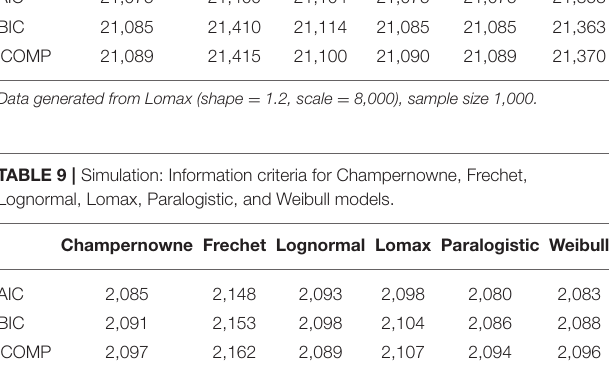
TABLE 3 | Simulation: Information criteria for Champernowne, Frechet, Lognormal, Lomax, Paralogistic, and Weibull models. Champernowne Frechet Lognormal Lomax Paralogistic Weibull AIC